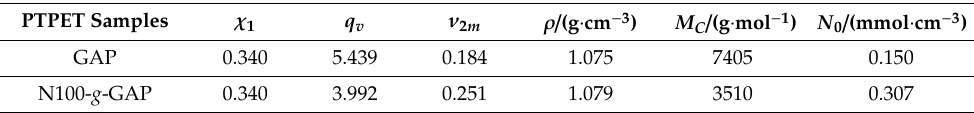
Figure 4. The apparent molecular weight ( M c ) ( A ) and the volume swelling ( B ) curves of PTPET prepared by N100- g -GAP and GAP ( Mn = 4000 g/mol). Table 1. Network parameters of the PTPET elastomer prepared by N100- g -GAP and GAP ( Mn = 4000 g/mol).